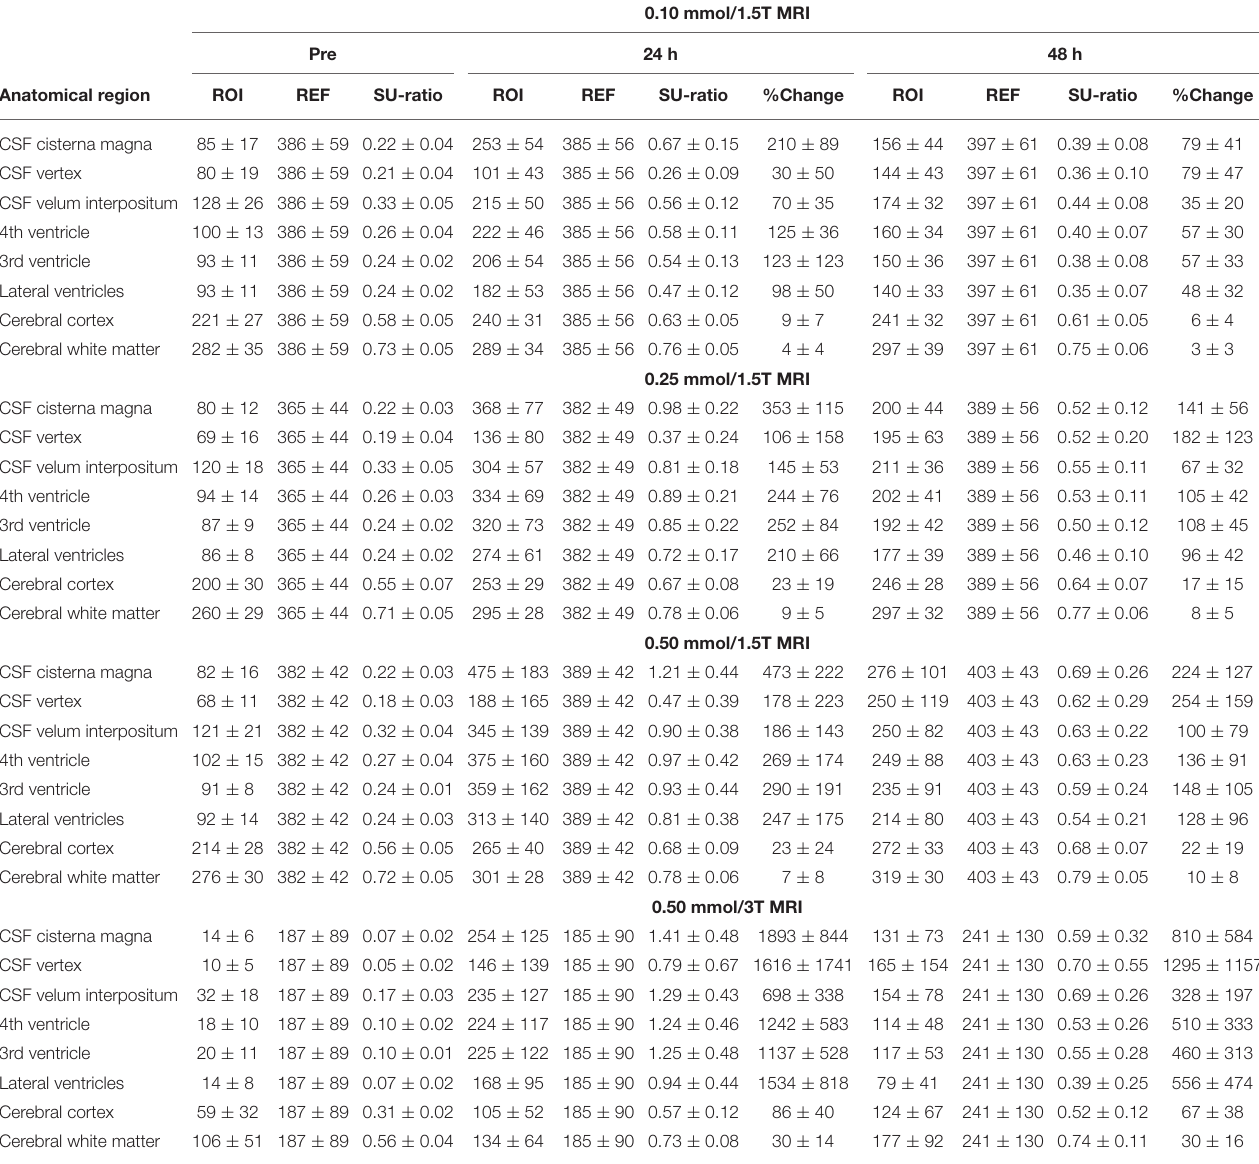
ROI, Region of interest for each anatomical region. REF, Reference region of interest within the posterior orbit. SU-Ratio, Signal unit ratio refers to signal unit within the particular region of interest (ROI) divided by the unit within the orbita serving as reference (REF). The percentage (%) change refers to the percentage change in signal unit ratio after 24 and 48h relative to before contrast